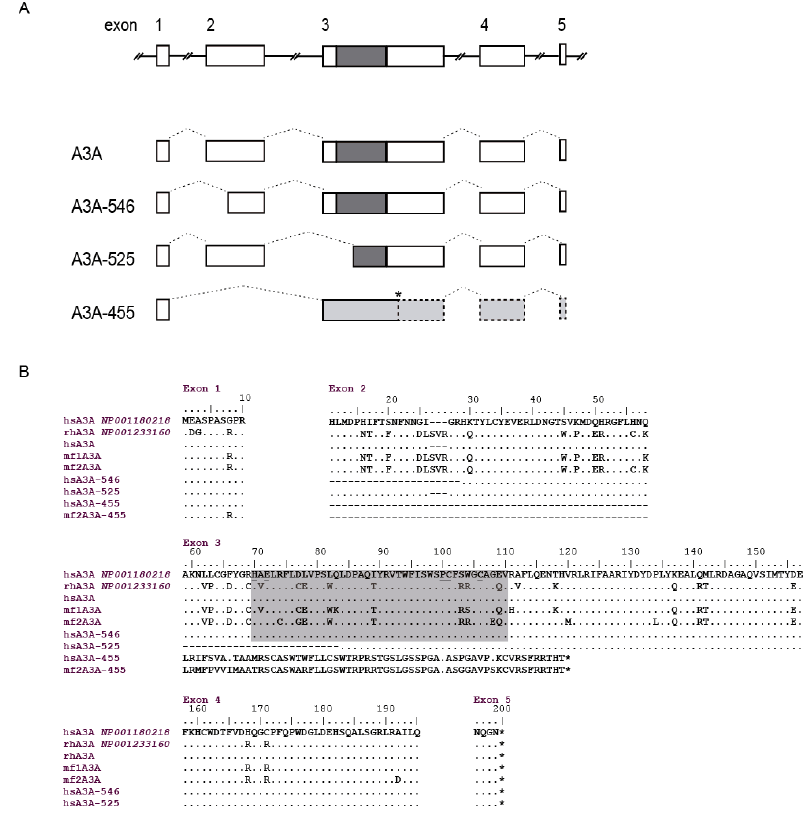
Figure 8. Human A3A transcripts. ( A ) Diagrams represent the different transcripts found in human A3A sequences obtained from PBMCs. Introns are represented by solid lines, exons by boxes and splicing sites by dotted lines. Coding regions, white; cytidine deaminase motif, dark grey; frameshift, light grey; and dotted line boxes: non-translated; ( B ) human A3A sequences obtained here from PBMC (hsA3A) were aligned with A3A sequences deposited in GenBank (with accession numbers) and A3A from macaca fascicularis (mf). Cytidine deaminase motif is highlighted in grey. Identical residues are identified by dots and absence of an amino acid by dashes. The numbering corresponds to that of the reference sequence.